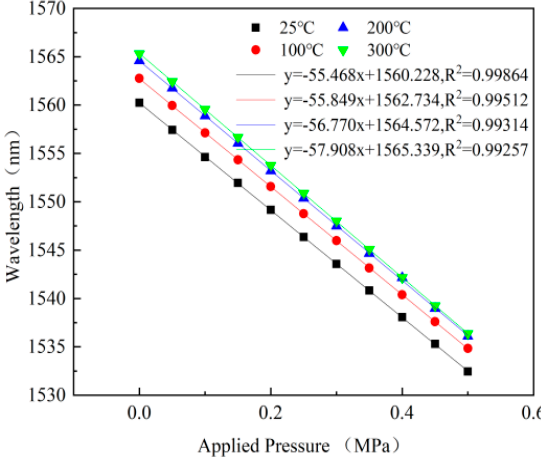
Figure 11. The relationship between peak wavelength and pressure at 25, 100, 200 and 300 °C.